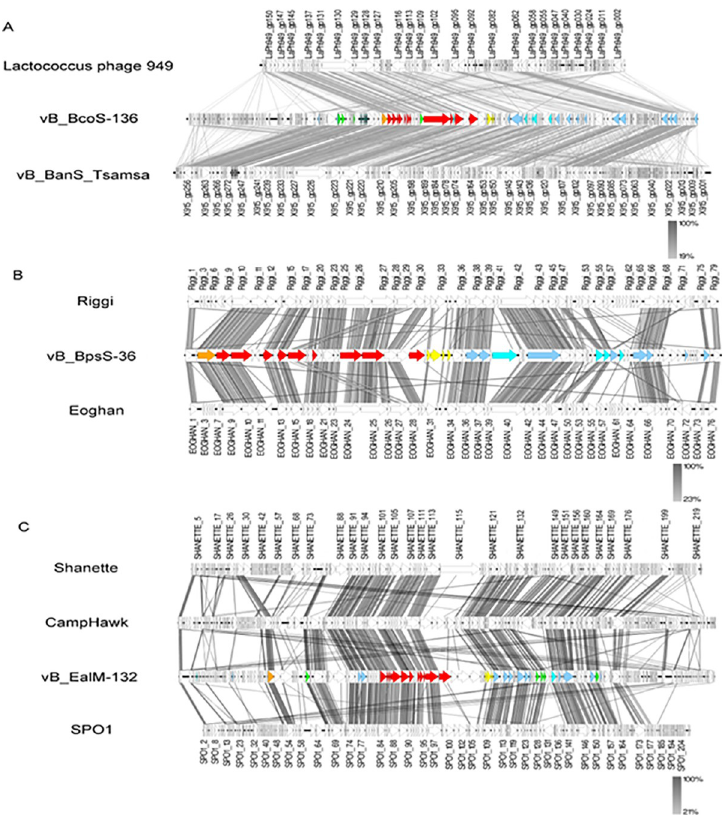
Fig 4. Genomic comparisons of vB_BcoS-136 (A), vB_BpsS-36 (B) and vB_EalM-132 (C) with related phages. Functional clusters are marked by the same color, namely DNA packaging (orange), structural components (red), lysis (yellow), regulation (green), replication (blue) and nucleotide metabolism (turquois). Synteny plot was generated with Easyfig with amino acid sequence comparison [33]. The amino acid sequence identity range is indicated by a gradient